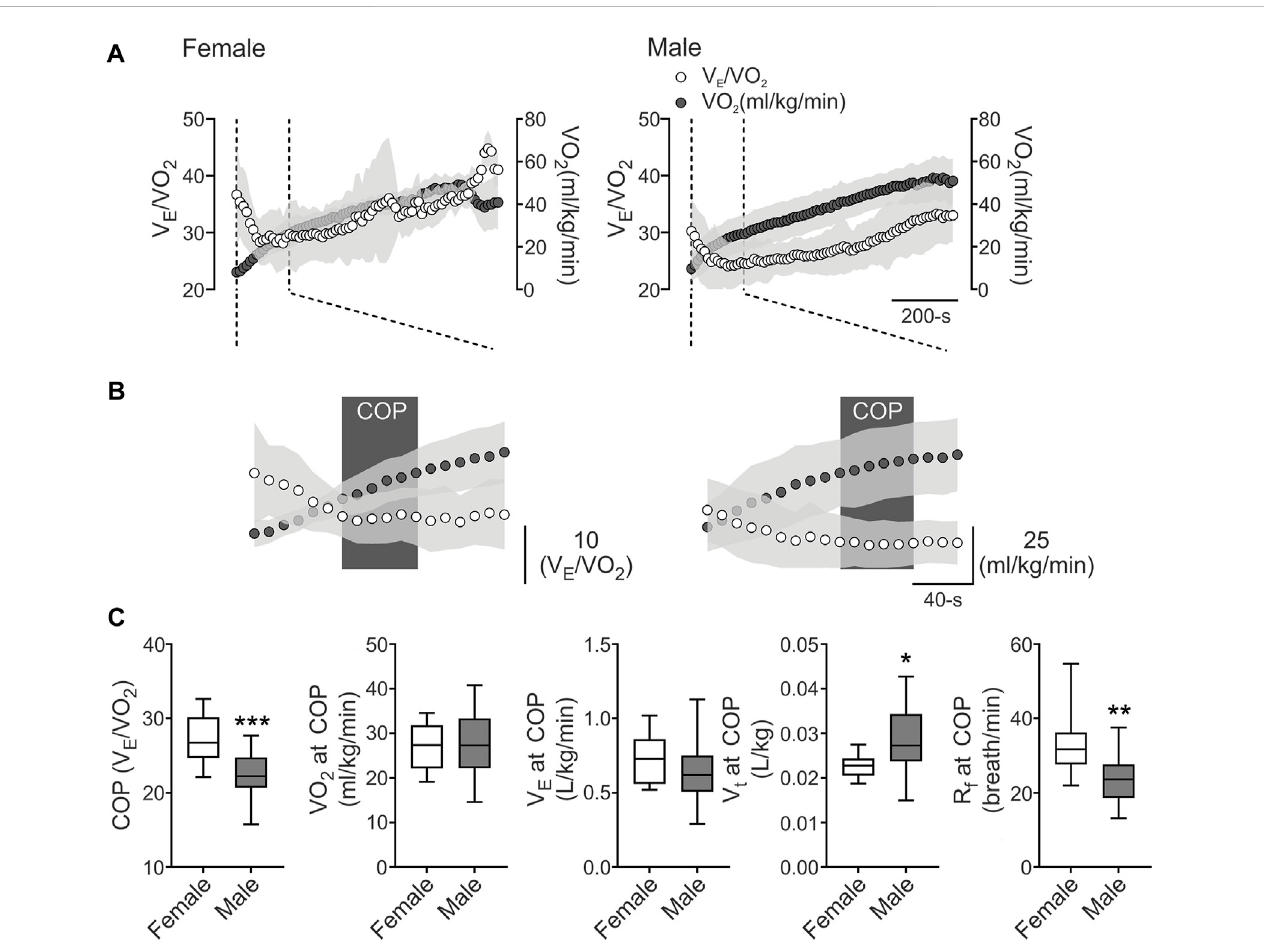
FIGURE 1 The cardiorespiratory optimal point between females and males. (A) , Representative VE/VO2 and VO2 recording from one female and one male well- trained athlete. (B) , Representation of cardiorespiratory optimal point (COP) determined by minute ventilation/oxygen consumption (VE/VO2). Note that males displayed a lower COP value compared to female participants. (C) , Summary data of COP and VO2, VE, tidal volume (VT), respiratory frequency (Rf) at COP (from left to right, respectively). Male participants displayed a higher COP and VO2 at COP and VT compared to female athletes. Also, males displayed a decrease in Rf compared to females. Unpaired T-test, *, p < 0.05; **, p < 0.01; and ***, p < 0.001. Female, n = 9; and Male, n =